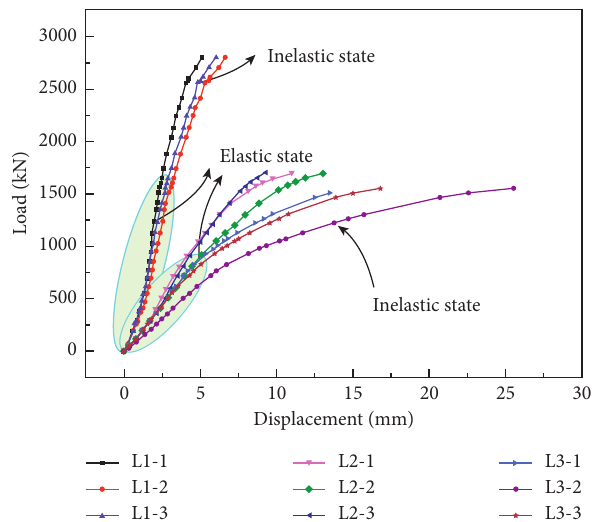
Figure 16: Load-bottom plate tensile strain relationship. Figure 14: Load-displacement curves of the test beam.